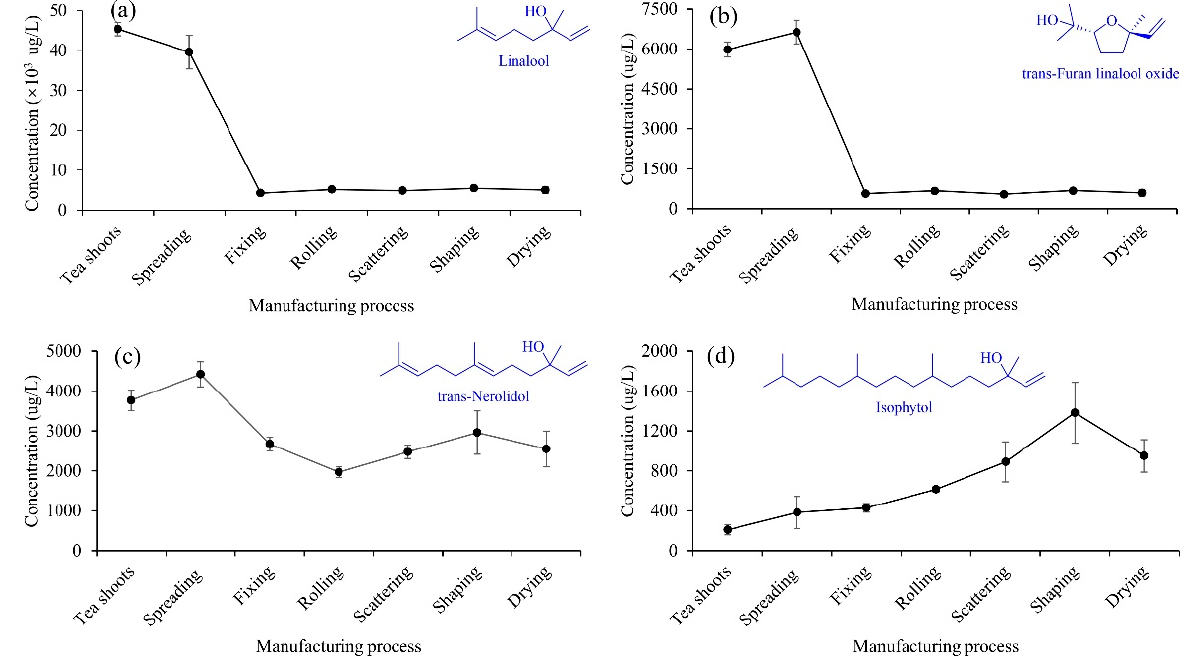
Figure 3. Changes in the concentrations of linalool ( a ), trans-furan linalool oxide ( b ), trans-nerolidol ( c ) and isophytol ( d ) during the XYMJ green tea manufacturing.